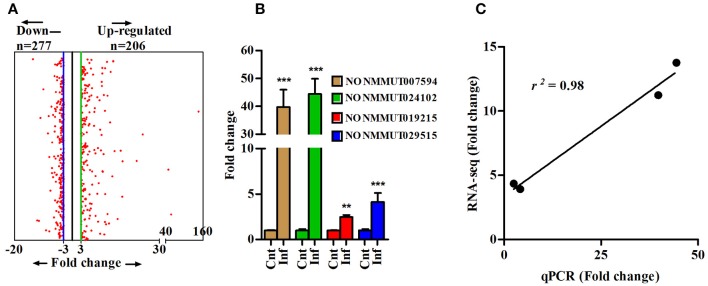
Differentially expressed lncRNA transcripts in lungs of mouse infected with R. conorii. (A) Differentially expressed lncRNA transcripts (n = 3, control and infected mice) based on Min/Max method (3-fold cut-off); (B) Validation of expression of four randomly selected up-regulated lncRNA transcripts (from RNA-sequencing analysis) by qPCR in infected mouse lungs (n = 4). The error bars represents standard error of mean (SEM) and the level of significance are shown as **P ≤ 0.01, and ***P ≤ 0.001; and (C) Spearmann correlation of fold change of 4 lncRNA transcripts as determined by RNA sequencing and qPCR methods (r2 = 0.98, P < 0.001).